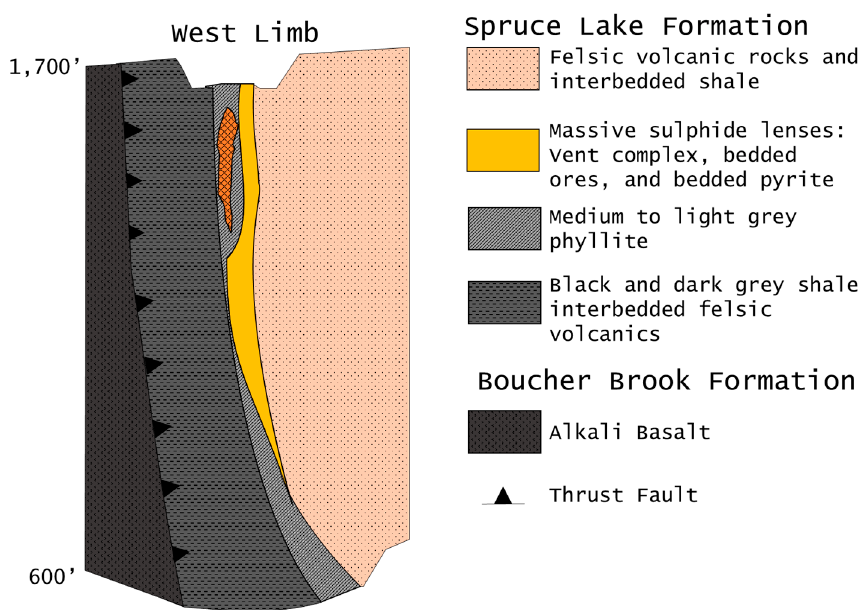
Figure 3. Cross-section of the west limb of the Caribou deposit, looking 7° west of north, which shows the massive sulphide lenses relative to the stratigraphic units of the Spruce Lake Formation and Boucher Brook Formation (modified from [4]).